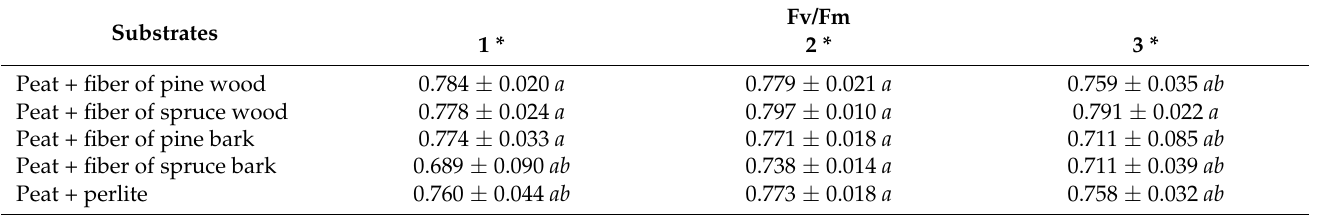
Table 5. Effect of mixes of peat with different amounts of wood and bark fibers and perlite on the chlorophyll fluorescence (Fv/Fm) of the blueberry saplings